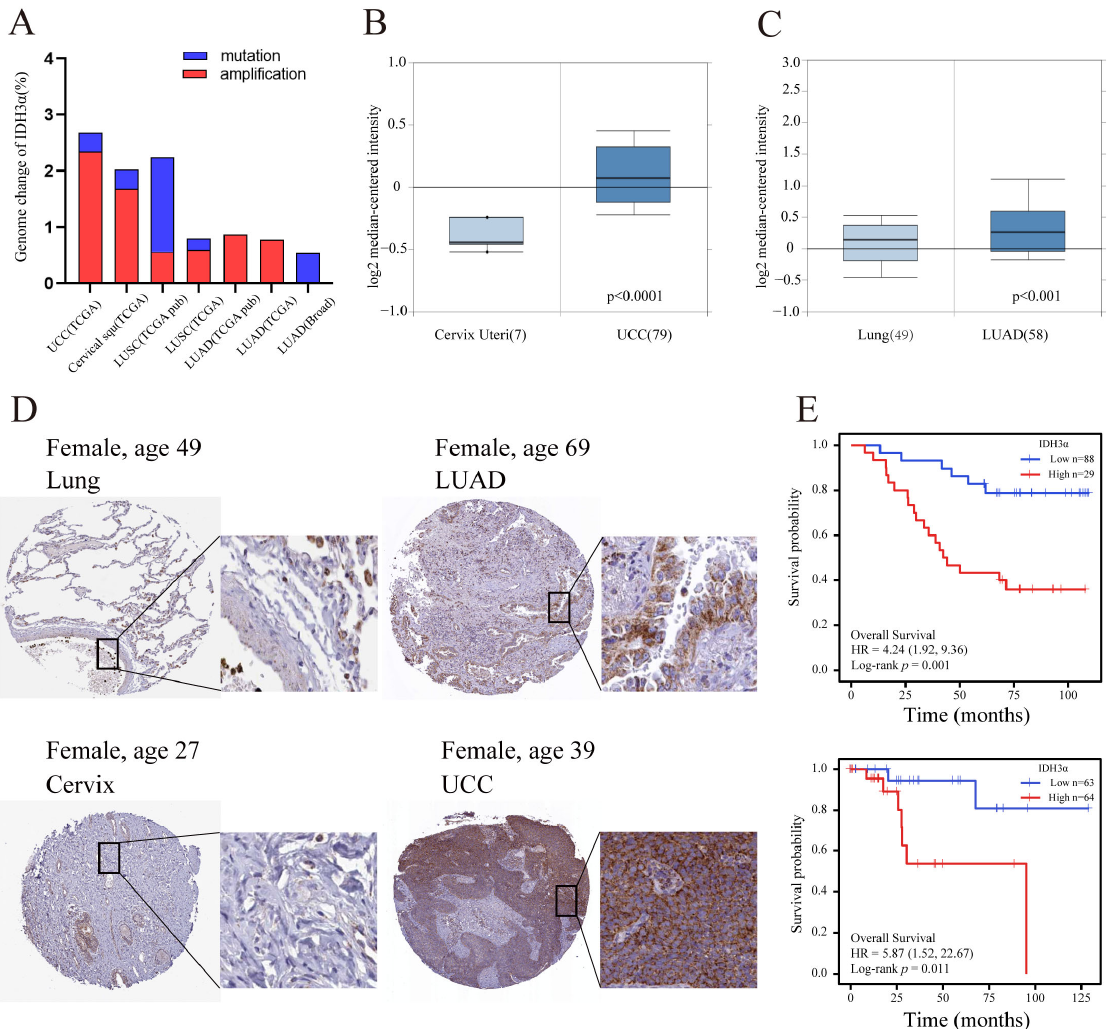
Figure 1. The expression level of IDH3 α and prognostic analysis in UCC and LUAD. ( A ) Genomic amplification and mutation of IDH3 α in UCC and lung cancer (data from TCGA). ( B ) The expression of IDH3 α in cervical cancer and normal cervix tissues was analyzed by using the Oncomine database (T > N). ( C ) The expression of IDH3 α in LUAD and normal lung tissues was analyzed by using the Oncomine database (T > N). ( D ) IHC staining of IDH3 α in lung cancer and normal lung tissue (upper), as well as cervical cancer and normal cervical tissue (lower), in the HPA database. ( E ) The KM method was used to establish survival curves, and the log-rank test was used to compare survival curves across subgroups. (Upper) LUAD, (lower) UCC. Data are shown as mean ± SD.